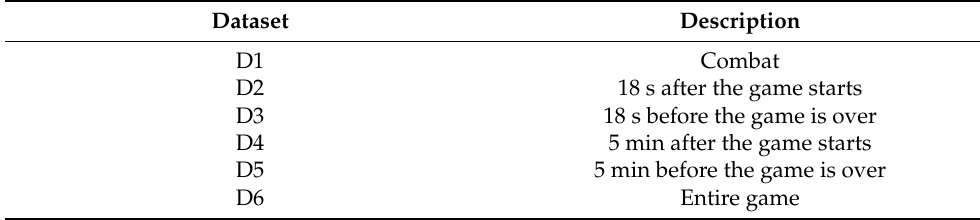
Table 2. Descriptions of six